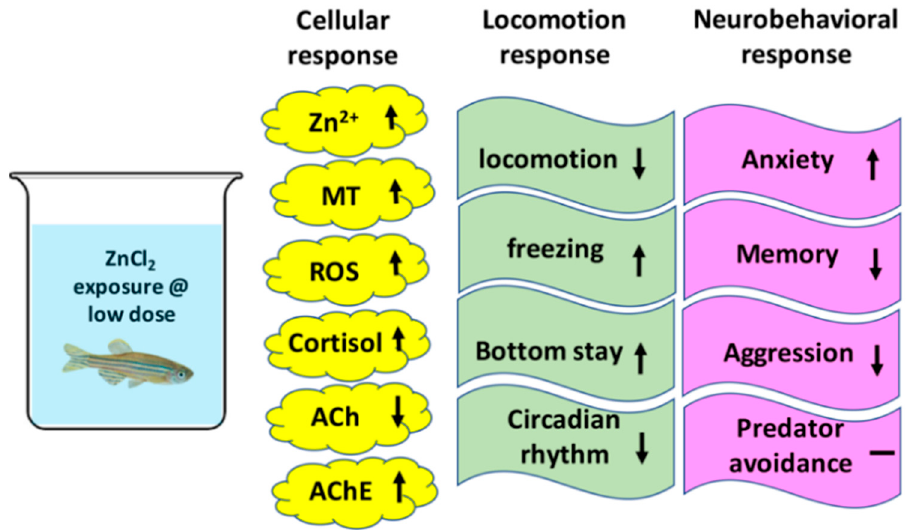
Figure 9. Summary of the toxicological effects of ZnCl 2 on cellular, locomotion, and neurobehavioral responses in adult zebrafish.